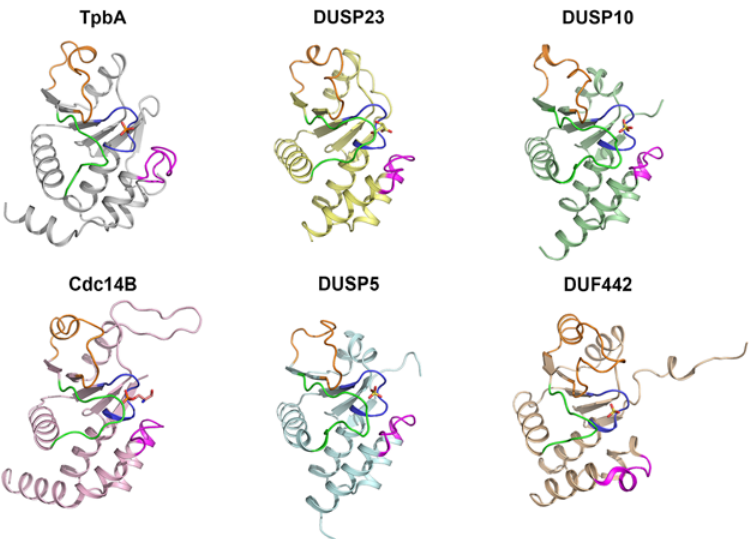
Fig 2. Comparison of TpbA with its closest structural homologs. A: Crystal structures of TpbA (grey), DUSP23 (PDB ID: 2IMG, pale yellow), DUSP10 (PDB ID: 1ZZW, pale green), Cdc14B (PDB ID: 1OHE, light pink), DUSP5 (PDB ID: 2G6Z, pale cyan) and DUF442 (PDB ID: 3GXG, wheat). Functionally important loops are coloured as follows: PTP loop, blue; general acid loop, green; variable insert, yellow; α 4- α 5 loop,